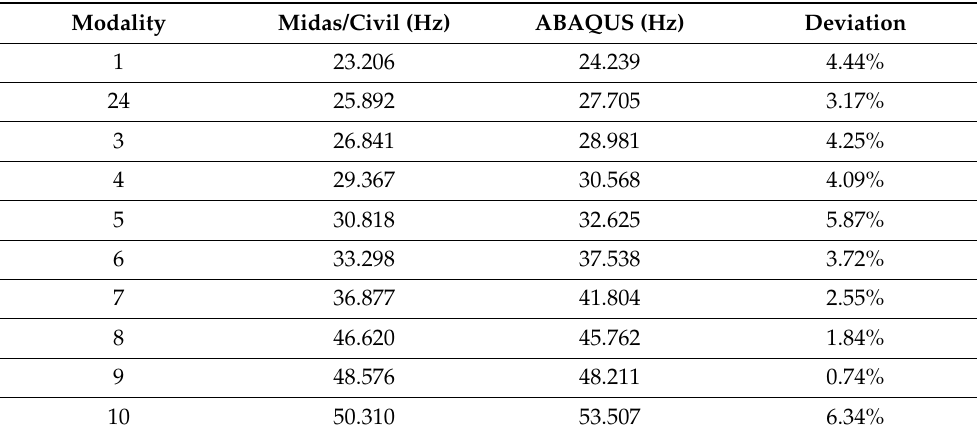
Figure 5. One-span model diagram of track and overhead system: ( a ) A cross model diagram type I aerial system. ( b ) A cross model diagram type II aerial system. Table 4. Vertical forward tenth order modal characteristic frequency.